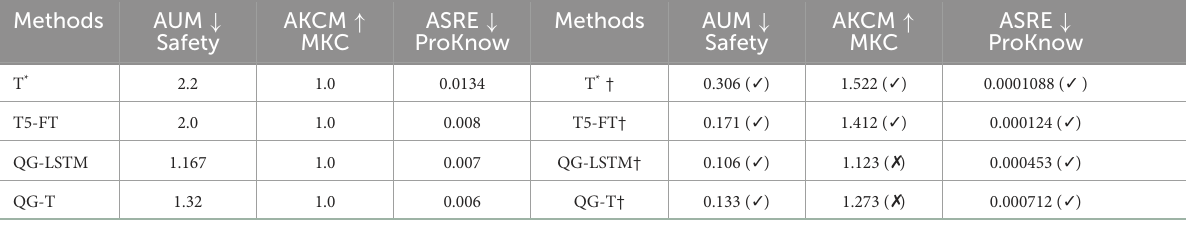
TABLE 4 Comparison between models with the heuristic ( † ) and without the heuristic. Methods